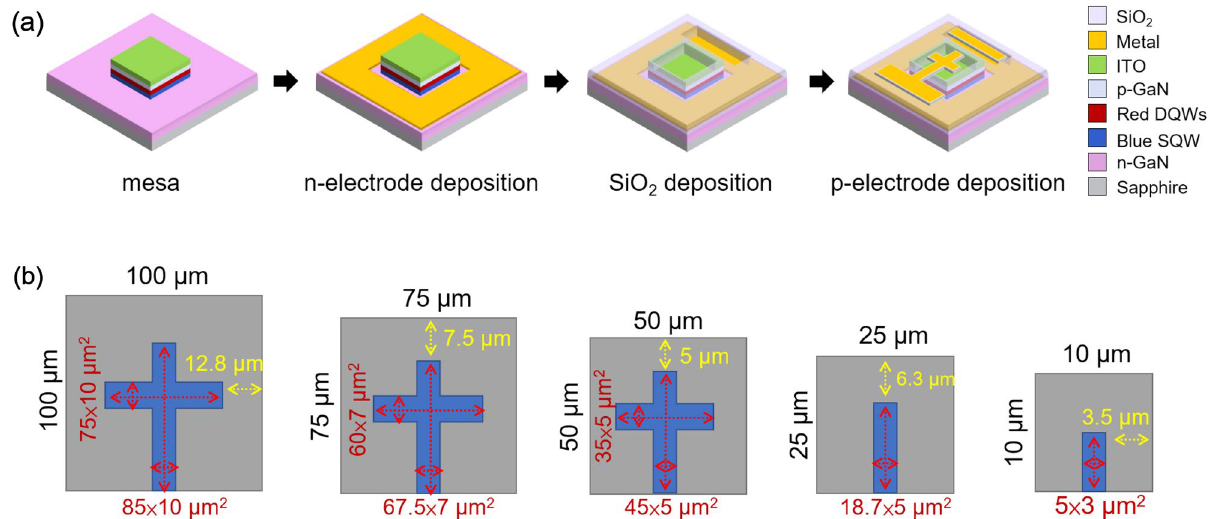
Figure 5. ( a ) Fabrication flowchart of μ-LEDs and ( b ) all the p-electrode dimensions of